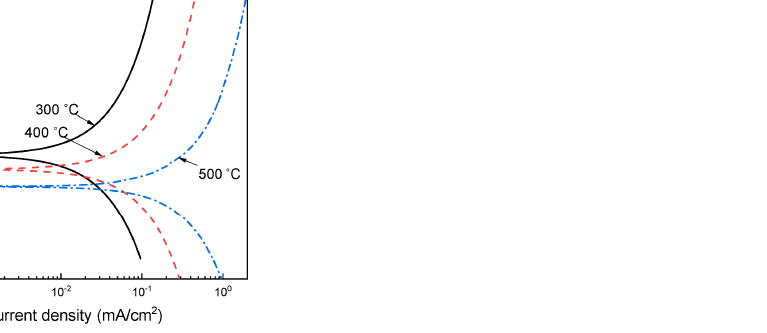
Figure 3. Effect of temperature on the variation of the polarization curves for T91 steel in 60 wt% NaNO 3 -40%KNO 3 . Table 1. Electrochemical parameters obtained from polarization